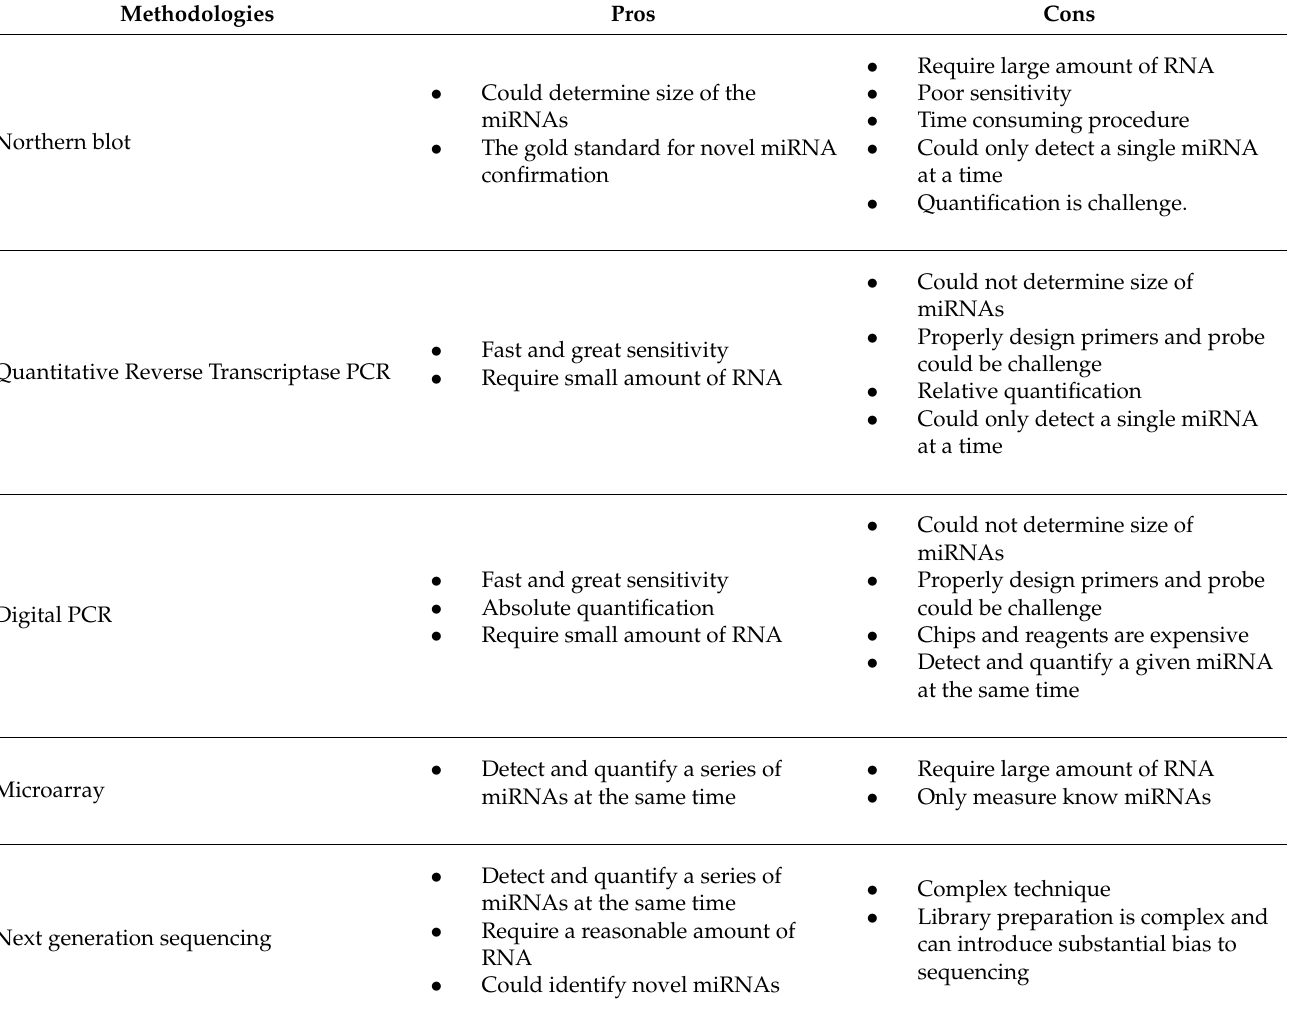
Table 1. Pros and cons of different methodologies utilized for circulating miRNA